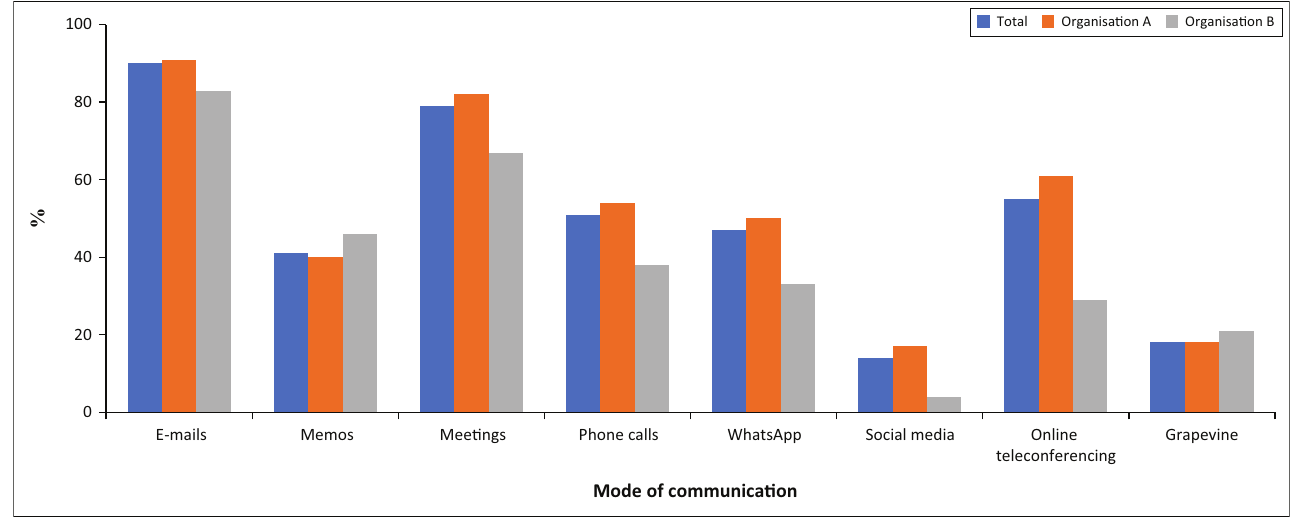
FIGURE 3: Usefulness of